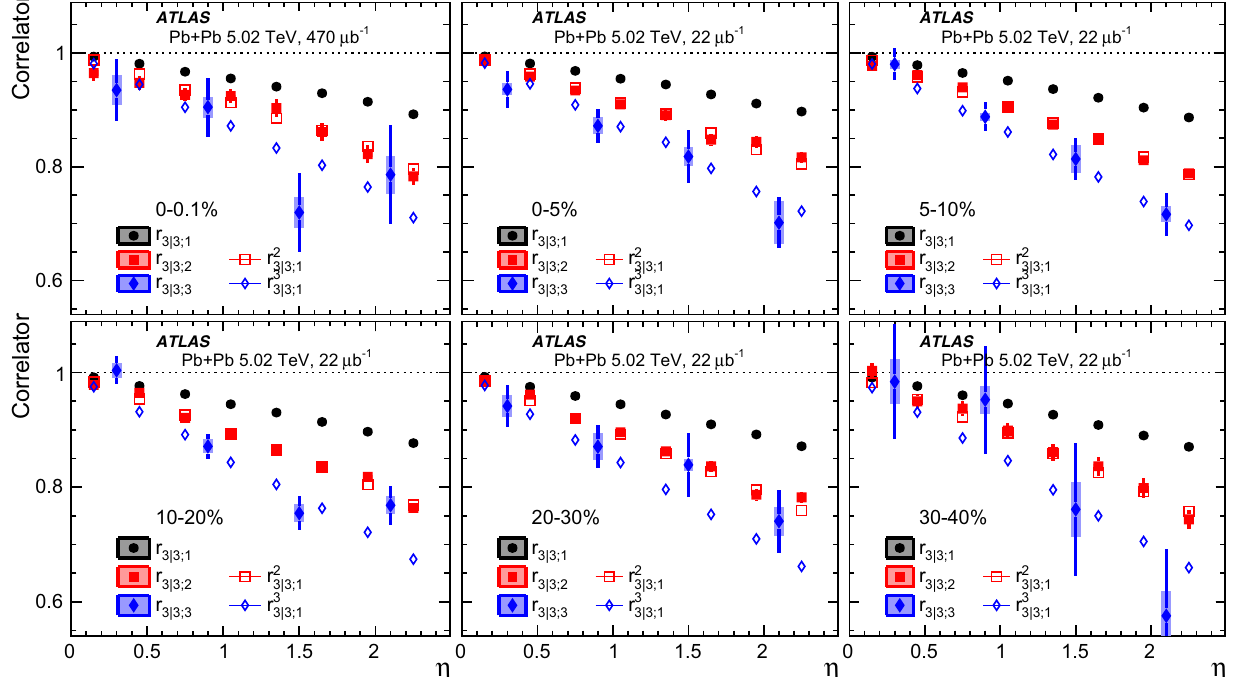
Fig. 16 The r 3 | 3 ; k for k = 1–3 compared with r k for k = 2–3 in various centrality intervals for Pb+Pb collisions at 5.02 TeV. The error bars 3 | 3 ; 1 and shaded boxes are statistical and systematic uncertainties, respectively. The data points for k = 2 or 3 in some centrality intervals are rebinned to reduce the